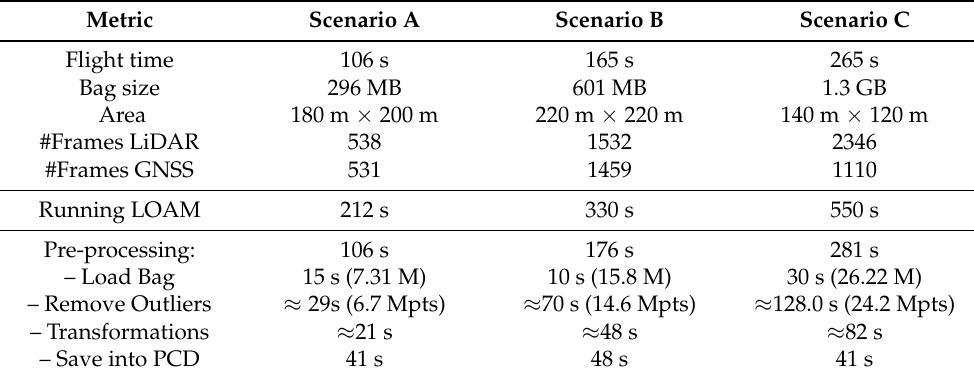
Table 1. Scouting phase: LOAM data properties, and pre-processing performance.